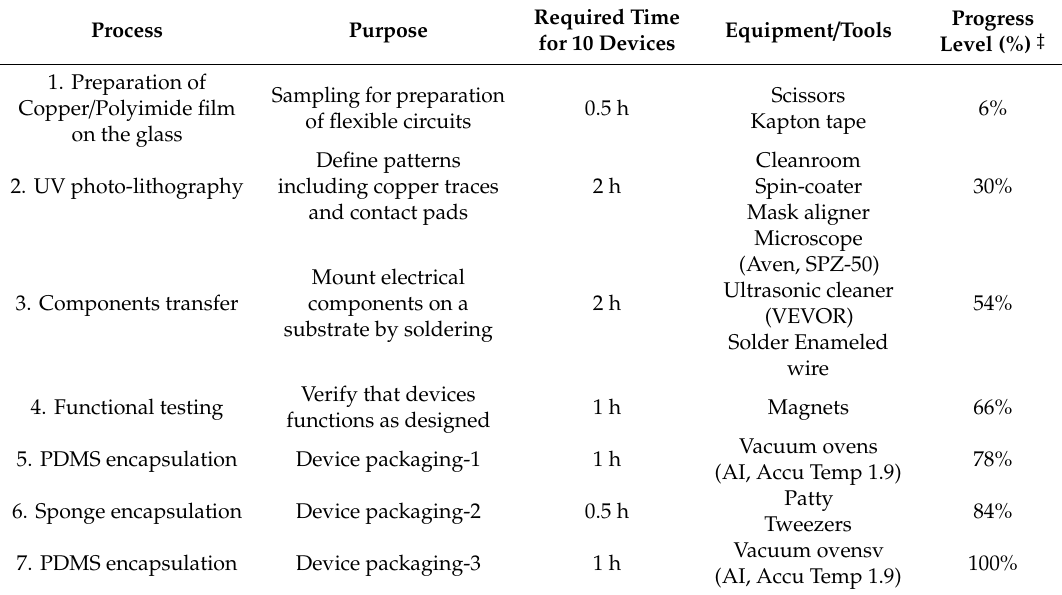
Table 1. Step-by-step procedures for fabrication and test of the surgical lighting